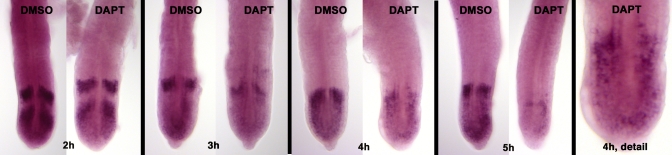
DAPT Treatment Disrupts Synchronized Oscillations of her1 within 3–4 hWild-type embryos were treated with 100 μm DAPT or with DMSO (control) medium and stained by ISH for her1 for 2, 3, 4, or 5 h, as indicated. The rightmost panel is a detail of the 4-h specimen, showing the chaotic pattern of expression of her1. Treatment was begun at the 16-somite stage. For each case, at least 14 embryos were examined, and typical specimens were selected for this illustration.